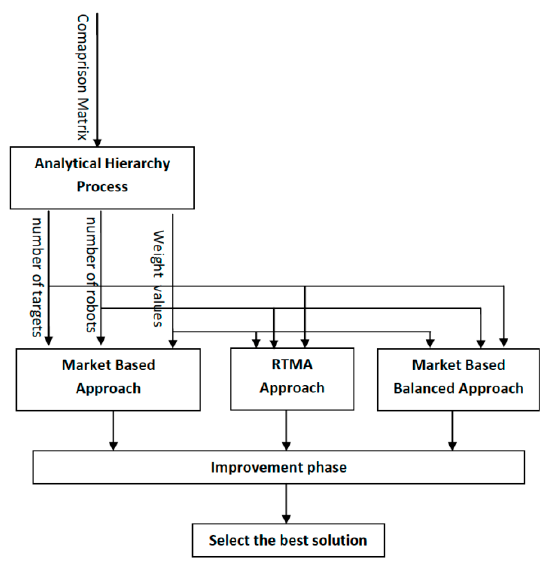
Figure 6. Flowchart showing the proposed AHP-MTSP approach.